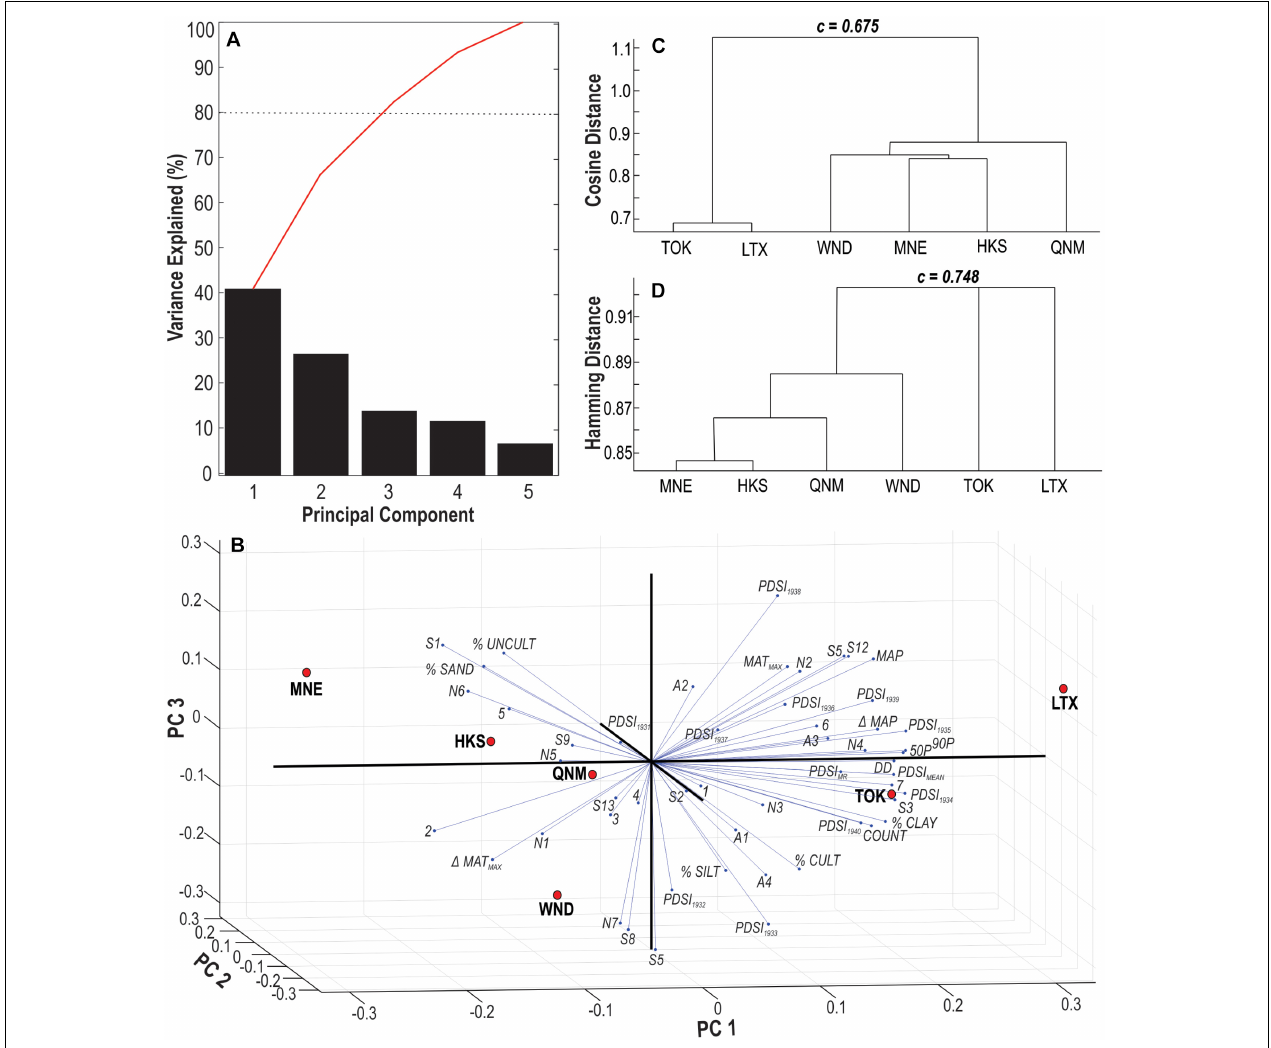
FIGURE 9 | Multivariate statistical analyses of surface types by location in Ward County, ND (WND), McPherson County, NE (MNE), Hamilton County, KS (HKS), Quay County, NM (QNM), Tillman County, OK (TOK) and Lamar County, TX (LTX): (A) Scree plot of principal components, (B) Triplot of the first three principal components, (C) dendrogram of hierarchical clusters measured by cosine distance and (D) hamming distance, with cophenetic correlation coefficient, c